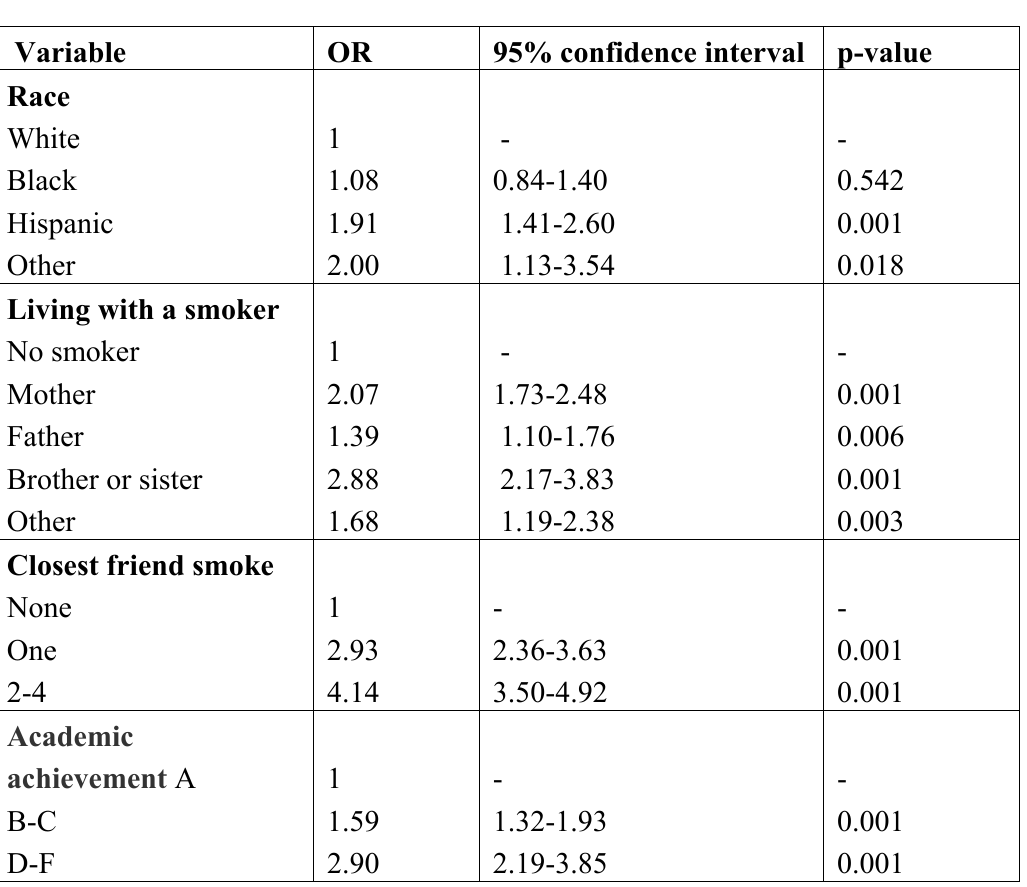
Table 4. Correlates of early initiation of smoking among adolescents in Northwest